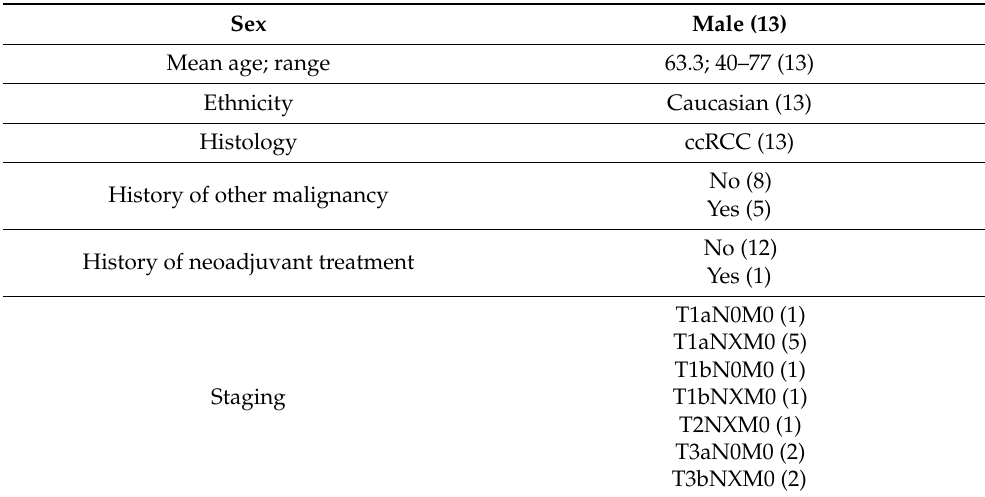
Table 2. Descriptive data of ccRCC-TTN group.